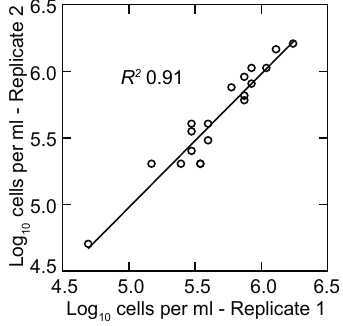
Figure 1. Scatter plot of replicate log-transformed counts of Borrelia hermsii cells in plasma samples from infected mice by phase microscopy and counting chamber. The linear regression and coefficient of determination ( R 2 ) are shown.